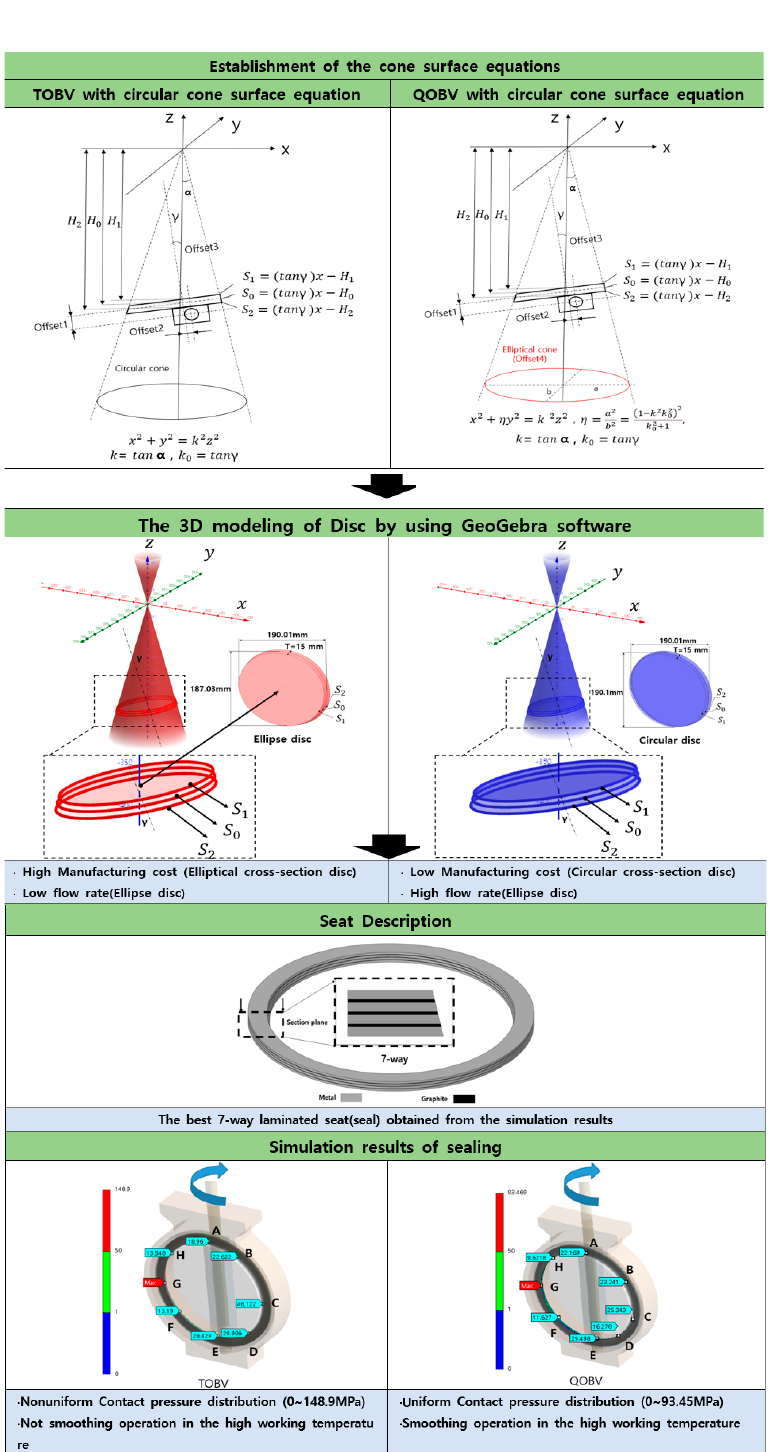
Figure 1. Con fi guration of di ff erences between the TOBV and the QOBV. Figure 1. Configuration of differences between the TOBV and the